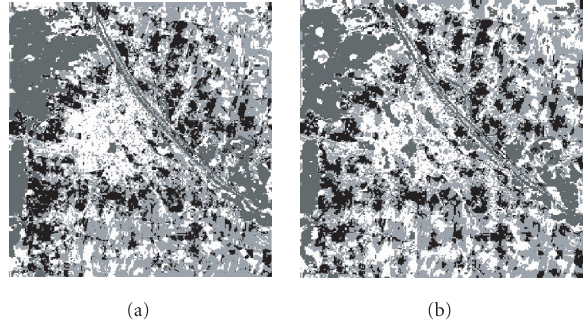
Figure 3: Main frequency spectrum of the deterministic part: (a) periodic spectrum; (b) directional spectrum.